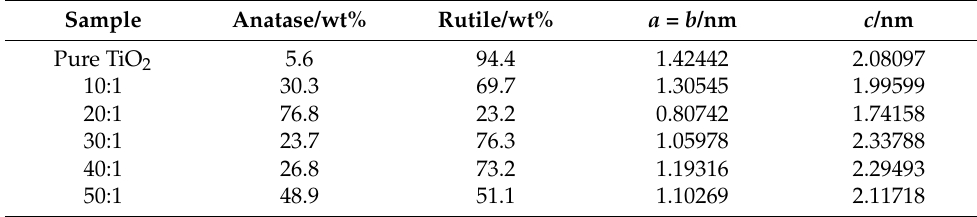
Figure 2. ( a ) XRD patterns of pure TiO 2 , g-C 3 N 4 and TCN-U x and ( b ) fitted curve between photocat- alytic degradation efficiency of AAF and ratio of TiO 2 anatase. Table 1. Crystalline phase ratio and cell parameters of pure TiO 2 and TCN-U x